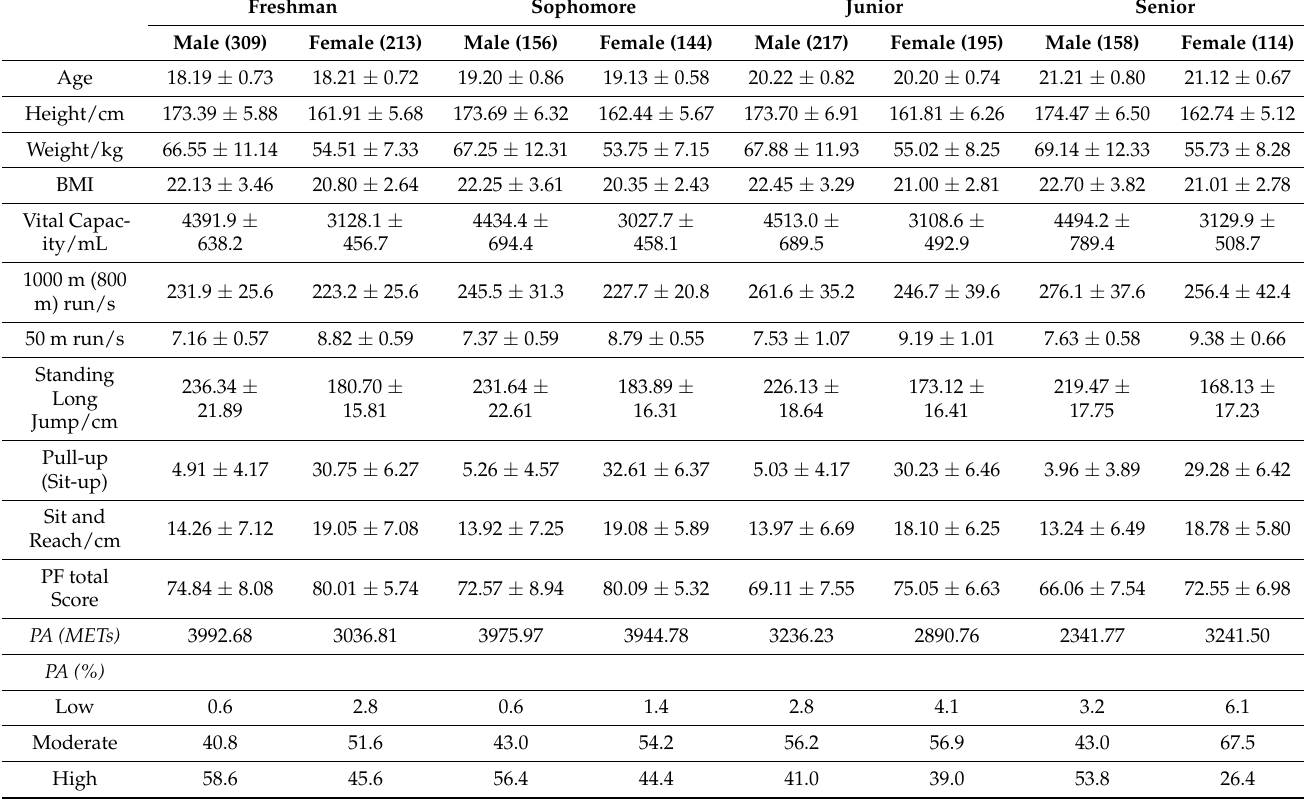
Table 4. Descriptive Statistics of Physical Activity and Physical Fitness in each academic